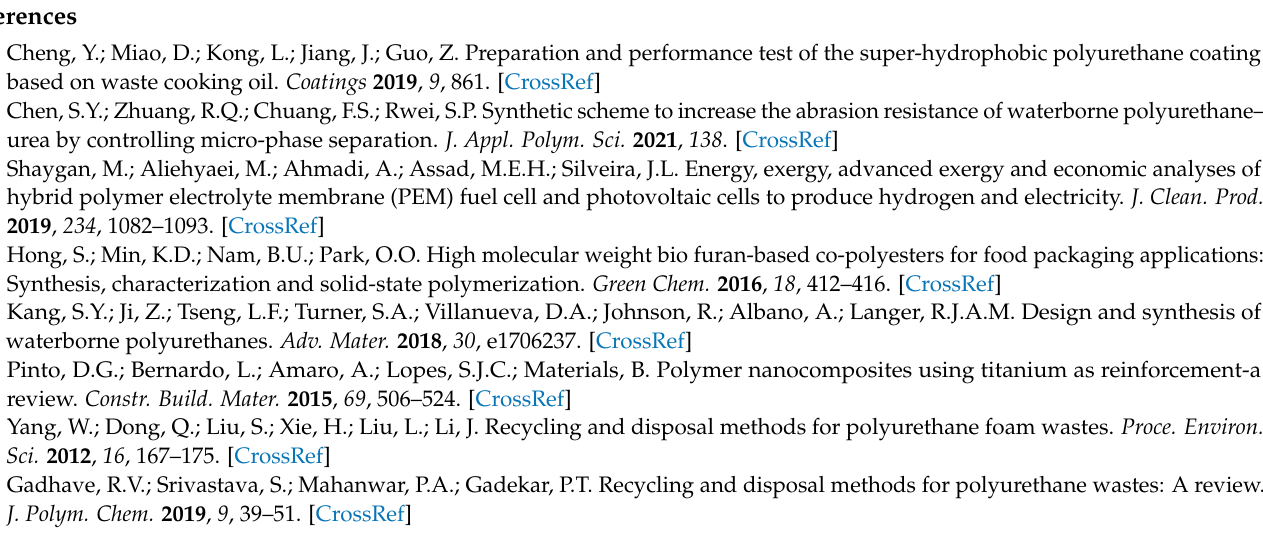
of BWPU 5000 and BWPU 10,000, Figure S1: 1 H-NMR spectra of PBI, PBI-PCL 5000 and PBI-PCL 10,000 , Figure S2: 1 H-NMR spectra of BDO-PCL 5000 and BDO-PCL 10,000 , Figure S3: FTIR spectra of BDO, BDO-PCL 10,000 , BWPU 10,000 and PWPU 10,000, Figure S4: The zeta potential distribution of PWPU and BWPU emulsions, Figure S5: The dissolution images of PWPU 10,000 under different solvents for 3 hours; (a) DMF; (b) NMP;(c) Acetone/Ethanol ( v/v = 2:1) (d) Acetone; (e) Ethanol, Figure S6: The dissolution images of BWPU 10,000 under different solvents for 3 hours; (a) DMF; (b) NMP; (c) Acetone/Ethanol ( v/v = 2:1) (d) Acetone; (e) Ethanol, Figure S7: Photos of BWPU 5000 (a) and PWPU 5000 (b) with a mass of 0.5 g dissolved in 4 mL of acetone/ethanol mixed-solvent ( v/v = 2:1) at 25 ◦ C for 3 h, Figure S8: Photos of BWPU 10,000 (a) and PWPU 10,000 (b) with a mass of 0.5 g dissolved in 4 mL of acetone/ethanol mixed-solvent ( v/v = 2:1) at 25 ◦ C for 3 h, Figure S9: Zeta potential distribution of recycled PWPU 5000 (a) and PWPU 10,000 (b) emulsions, Figure S10: (a) Stress – strain curves of PWPU 5000 after three-generations of recycling. The mechanical properties including the (b) breaking strength, and (c) breaking elongation for the PWPU 5000 samples after three times recycling process. (d) Photo of lifting a 10 kg weight by a PWPU 5000 film with the thickness of 0.3 mm after the recycling process, Figure S11: The shape memory behavior of BWPU 10,000 (a) and PWPU 10,000 (b) photos with original shape, temporary shape (deformed at 25 ◦ C for 20 min and fixed at 0 ◦ C for 20 min), and recovered state after being soaked in water at 70 ◦ C, Figure S12: Photos of BWPU 5000 shape recovery in water at 70 ◦ C, Movie S1: Video of PWPU 5000 shape recovery in water at 70 ◦ C, Movie S2: Video of BWPU 5000 shape recovery in water at 70 ◦ C, Movie S3: Video of PWPU 10,000 shape recovery in water at 70 ◦ C, Movie S4: Video of BWPU 10,000 shape recovery in water at 70 ◦